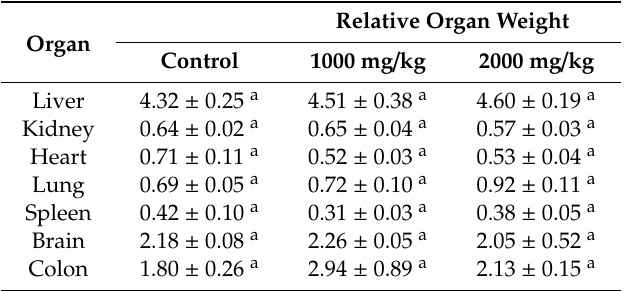
Table 2. E ff ects of IP 6 -CS-MNPs on relative organ